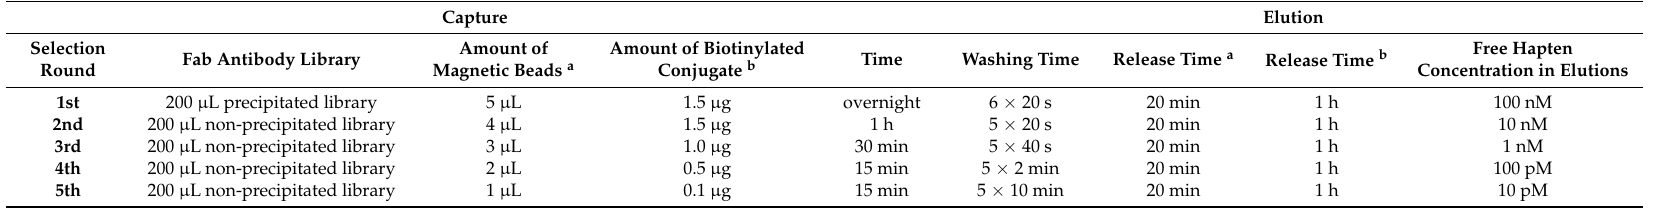
Table 1. A detailed summary of variables in the conditions of the selection rounds. Fab, fragment